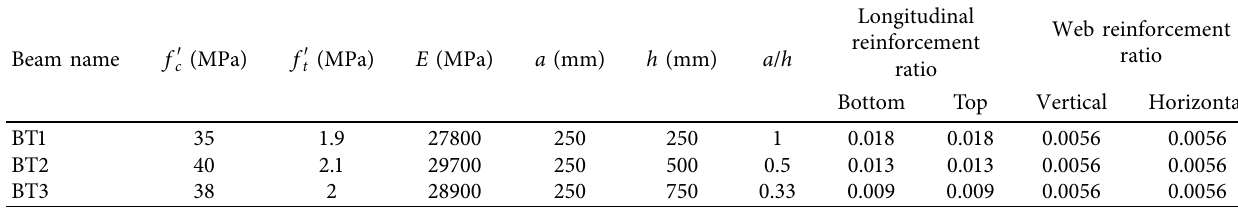
Table 1: Geometrical and reinforcement features of the specimens.